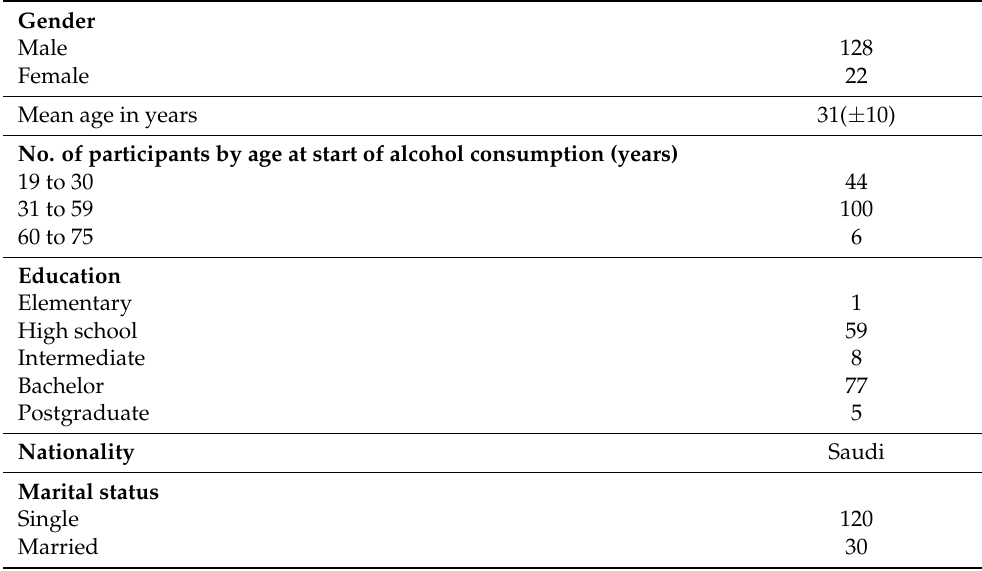
Table 2. Demographic profile of Group 2.